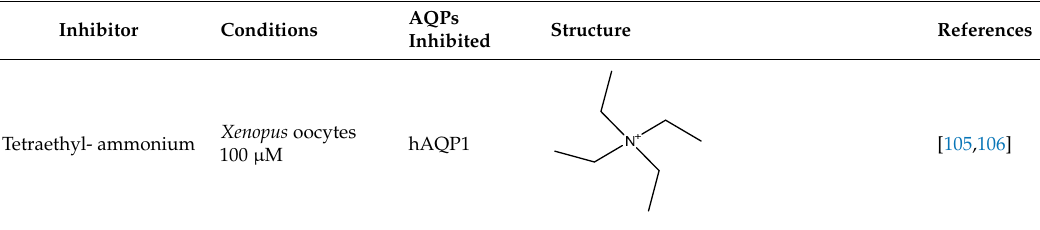
Table 3. Currently-available AQP inhibitors, their structures, the AQPs they inhibit (species are highlighted as h—human, m—mouse, and r—rat) and the conditions under which they were assayed.